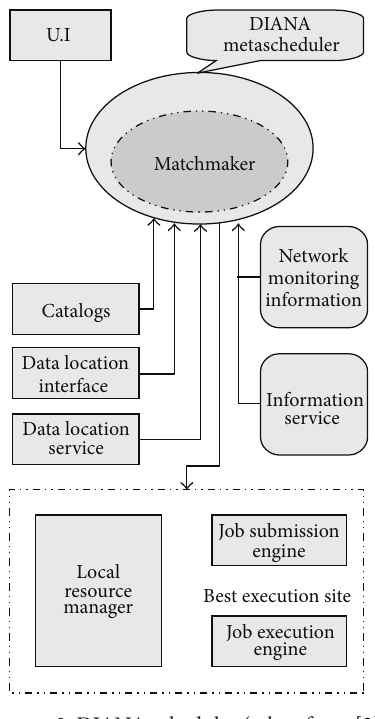
Figure 1: Resource brokerage with network bandwidth-aware Grid scheduling (taken from [6]).